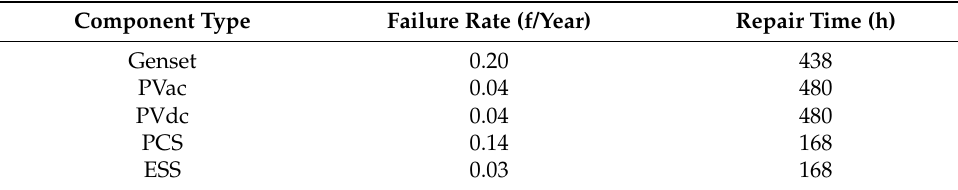
Table A3. Parameters for the contingency enumeration method [49].